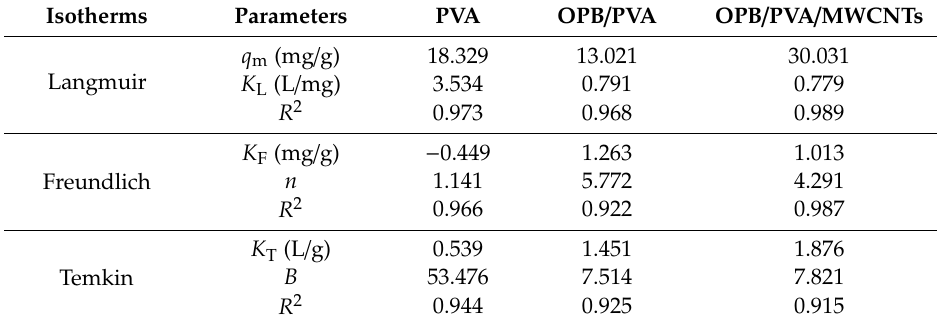
Figure 12. ( a ) Langmuir, ( b ) Freundlich and ( c ) Temkin isotherm models for PVA, OPB/PVA and OPB/PVA/MWCNTs adsorbents for Pb(II) removal at various concentrations (65–200 ppm) and pH 7. Experimental conditions: adsorbent dose = 0.5 g, pH = 7 and maximum adsorption time = 300 min (1, 3, 5, 10, 20, 30, 60, 120, 180, 240 and 300 min) at room temperature. Table 4. Isotherm parameters used for the Pb(II) removal over the PVA, OPB / PVA and OPB / PVA / MWCNTs